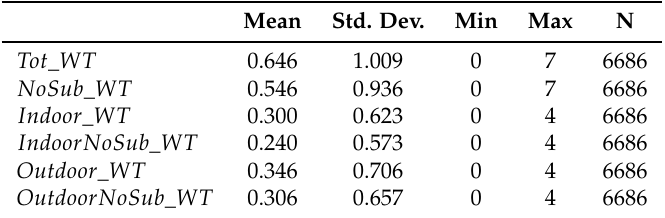
Table 2. Summary statistics—ATET estimation.